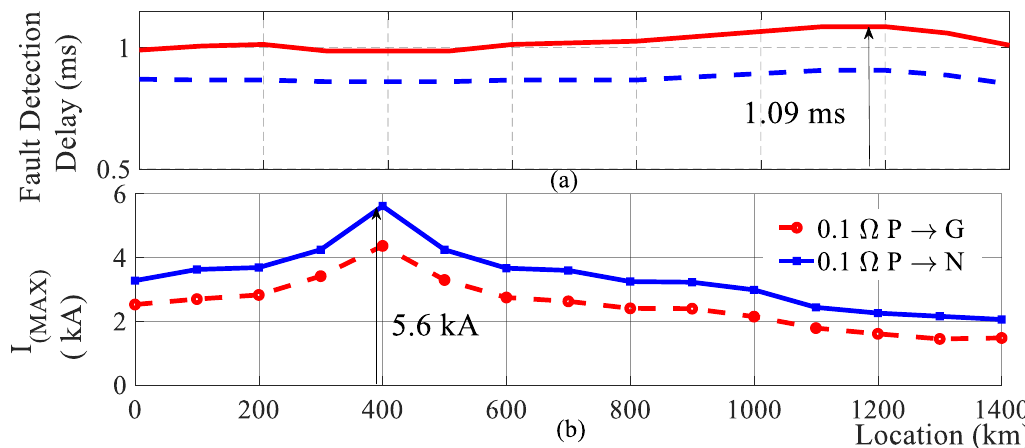
Figure 20. DC CB requirement ( a ) Fault detection speed, ( b ) Maximum dc CB current.